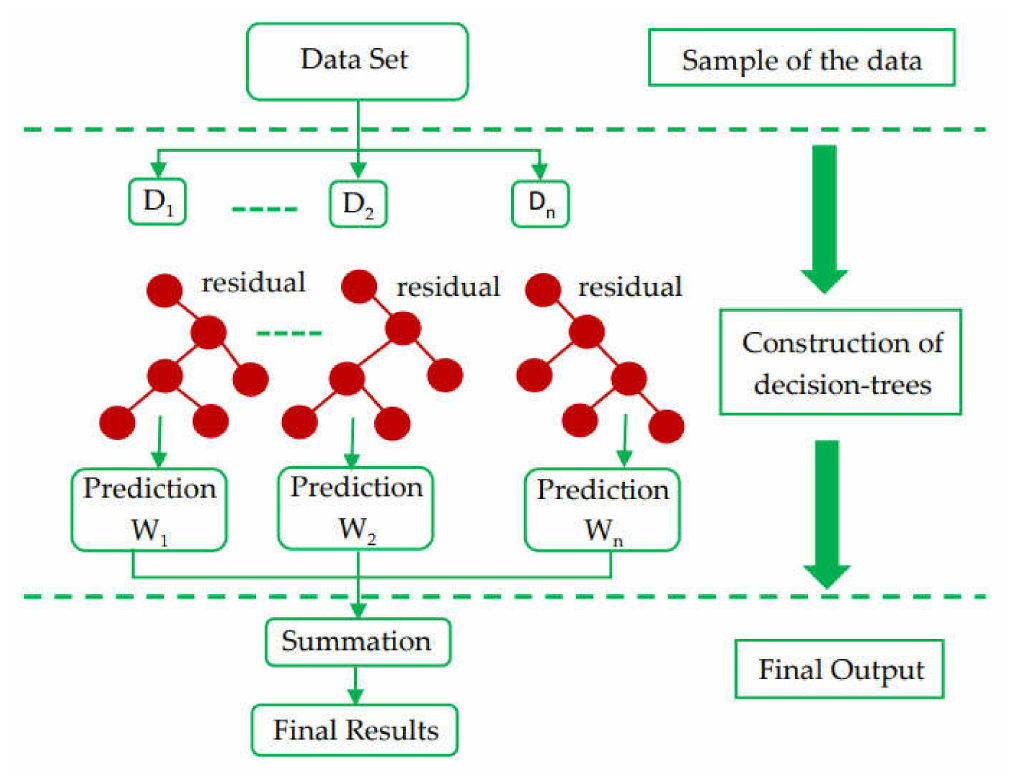
Figure 2. XGBoost (extreme gradient-boosting) algorithm structure